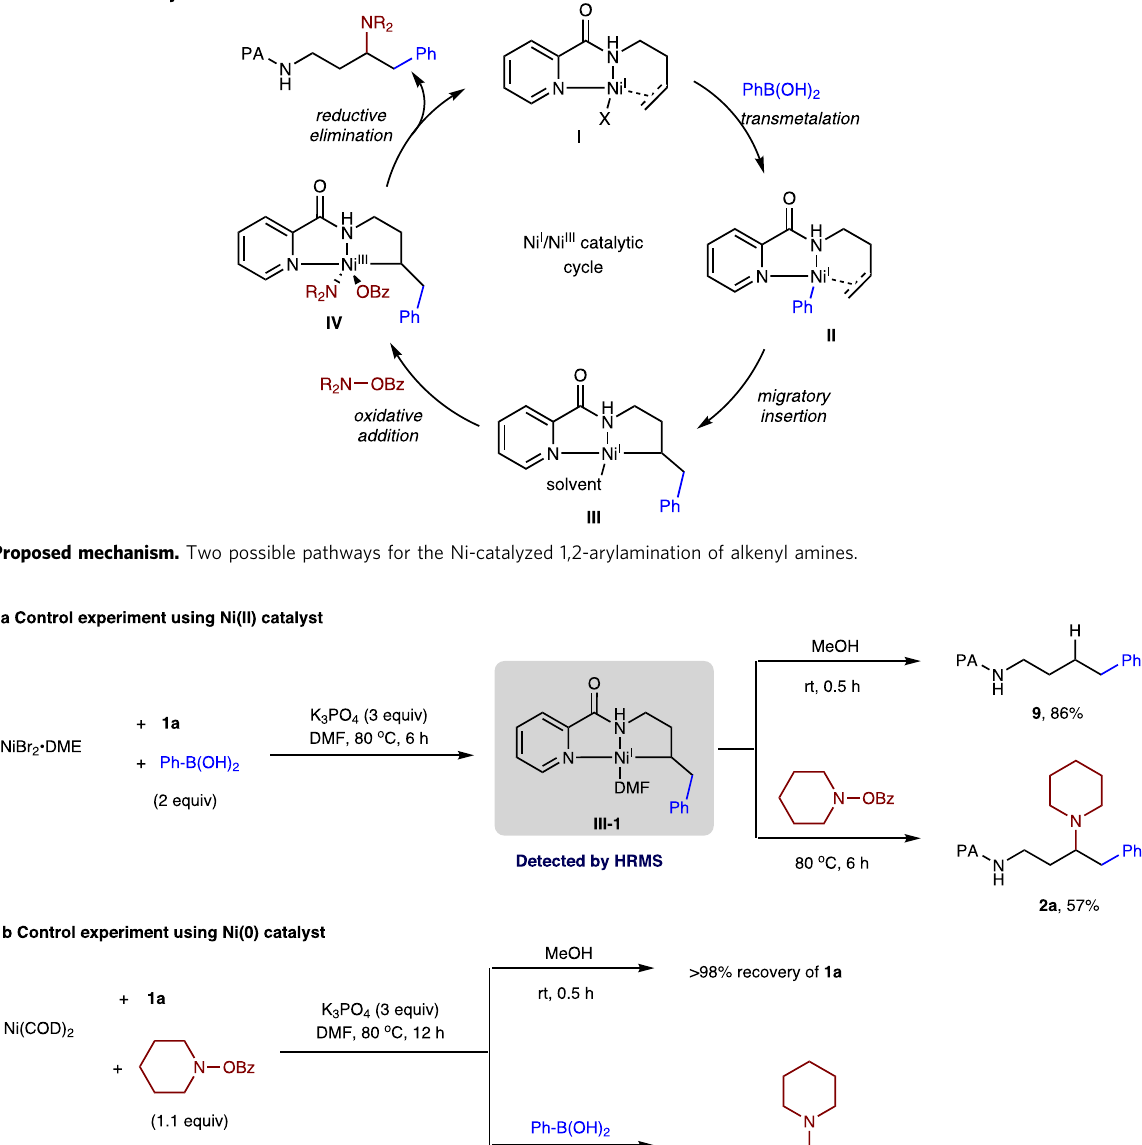
(0.4 mmol, 2 eq), appropriate arylboronic nucleophile (0.6 mmol, 3.0 eq), t -BuOH (2 mL) were added to a 10 mL schlenk fl ask. The reaction mixture was stirred at 80 °C for 24h and the resulting solution was concentrated in vacuum. The crude product was puri fi ed by column chromatography on alumina gel with a mixture of